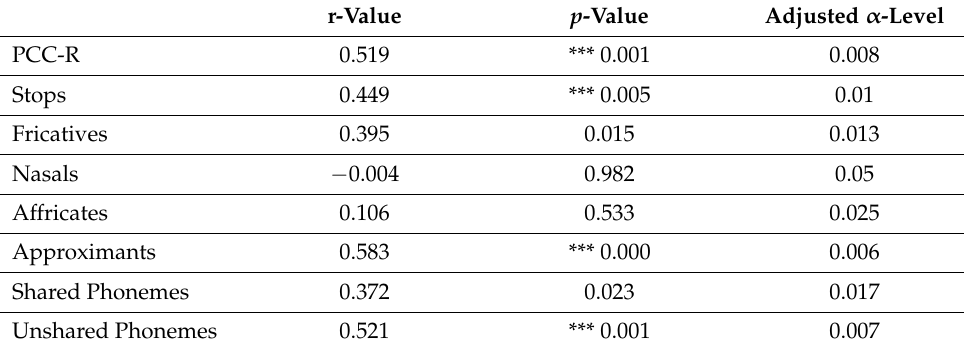
Table 3. Bivariate correlations between maternal Anglo-American orientation (AOS) scores and